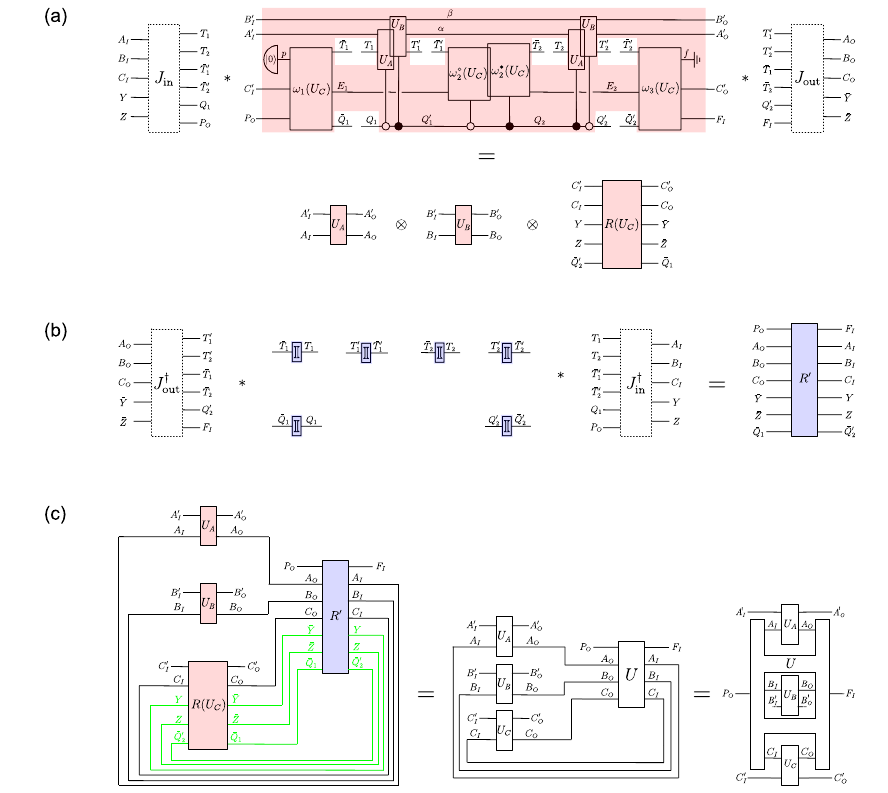
Fig. 4 | Description of the tripartite temporal circuit in terms of time- delocalised subsystems. a Description of the red circuit fragment in terms of the time-delocalised subsystems A I , B I , C I , Y , Z of the joint system T 1 T 2 (cid:2) T 0 1 (cid:2) T 0 2 Q 1 P O , and A O , B O , C O , (cid:2) Y , (cid:2) Z of the joint system T 0 1 T 0 2 (cid:2) T 1 (cid:2) T 2 Q 0 2 F I . c The composition of the operations R ( U C ) and R 0 over the systems Y , (cid:2) Y , Z , (cid:2) Z , (cid:2) Q 1 , (cid:2) Q 0 2